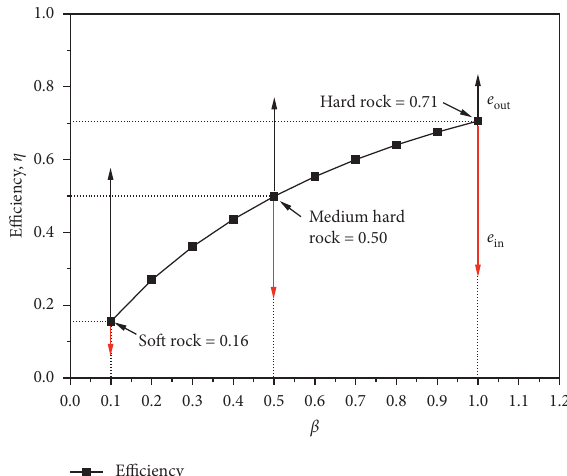
Figure 3: Drilling energy transfer efficiency of a DTH hammer with respect to β